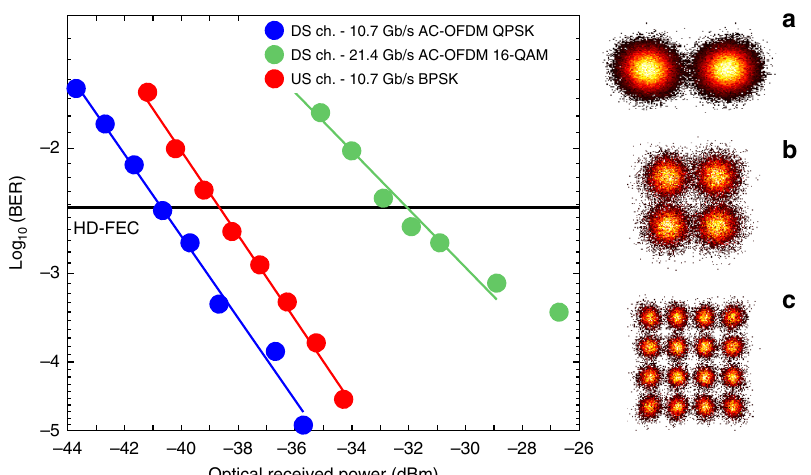
Fig. 5 BER vs received power for the DS and US signals in single-channel operation. Insets: received a 10.7 Gb/s BPSK, b 10.7 Gb/s Alamouti-coded OFDM QPSK, and c 21.4 Gb/s Alamouti-coded OFDM 16-QAM constellations around the HD-FEC threshold, assumed to be 4 × 10 − 3 . AC-OFDM: Alamouti-coded